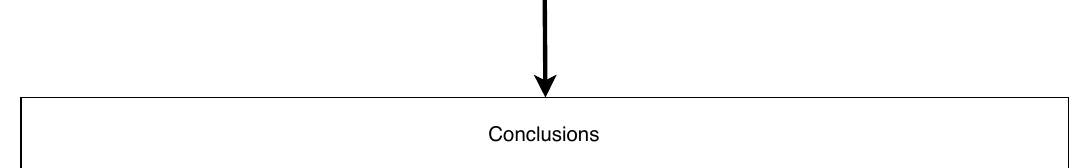
Figure 1: Research